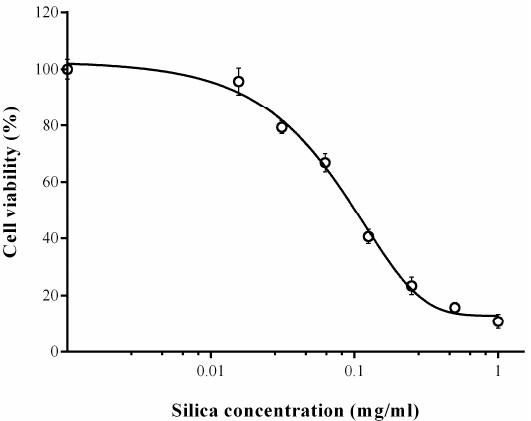
Figure 6. Cell viability after horsetail-derived silica treatment. The cytotoxicity of the prepared powder is presented as the percentage of viability of treated cells compared to untreated cells, whose viability was assumed to be 100%. The data points present the mean ± SD of three independent experiments.